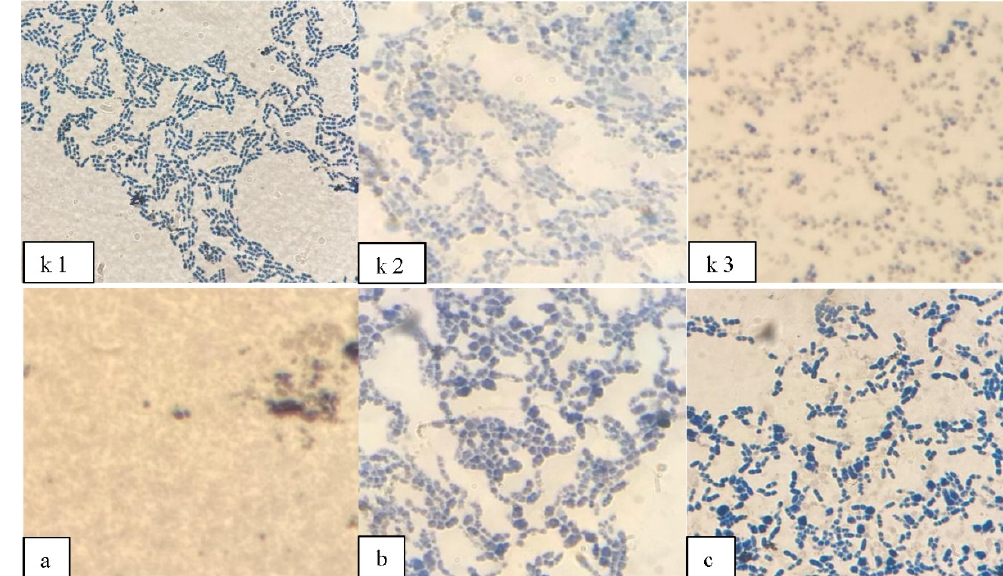
Figure 2. Cells stained after UV irradiation for 10 min: ( a )— Bacillus pumilus Ra 1; ( b )— Bacillus megaterium RA 5 and ( c )— Azotobacter chrocococcum RAZ 3. Control samples, without UV irradiation: ( k 1 )— Bacillus pumilus Ra 1, ( k 2 )— Bacillus megaterium RA 5, ( k 3 )— Azotobacter chrocococcum RAZ 3. Table 3. Effect of bean broth concentration in mineral medium on synthesis of P(3HB) by RAZ3